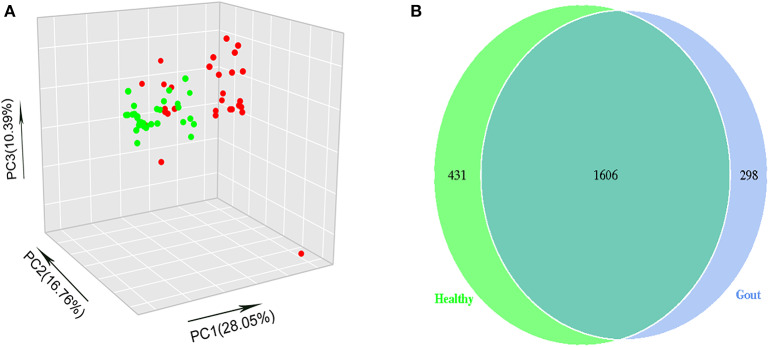
(A) The beta-diversity indices between gout patients (red) and healthy controls (green) are shown in PCoA analysis. The ordination plot shows a clear difference between the two groups. (B) Venn diagrams show the percentage of shared OTUs between gout patients and healthy controls. The results show that a total of 1606 OTUs were shared between two groups, which accounted for 84.34% of the total OTUs in healthy controls and 78.84% of the total OTUs in gout patients.